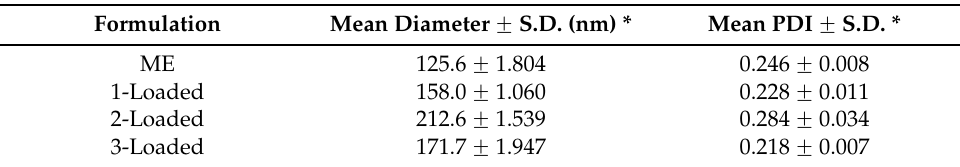
Table 3. Determination of the droplet size and polydispersity index of the nanostructured lipid system (MEs) using light scattering.